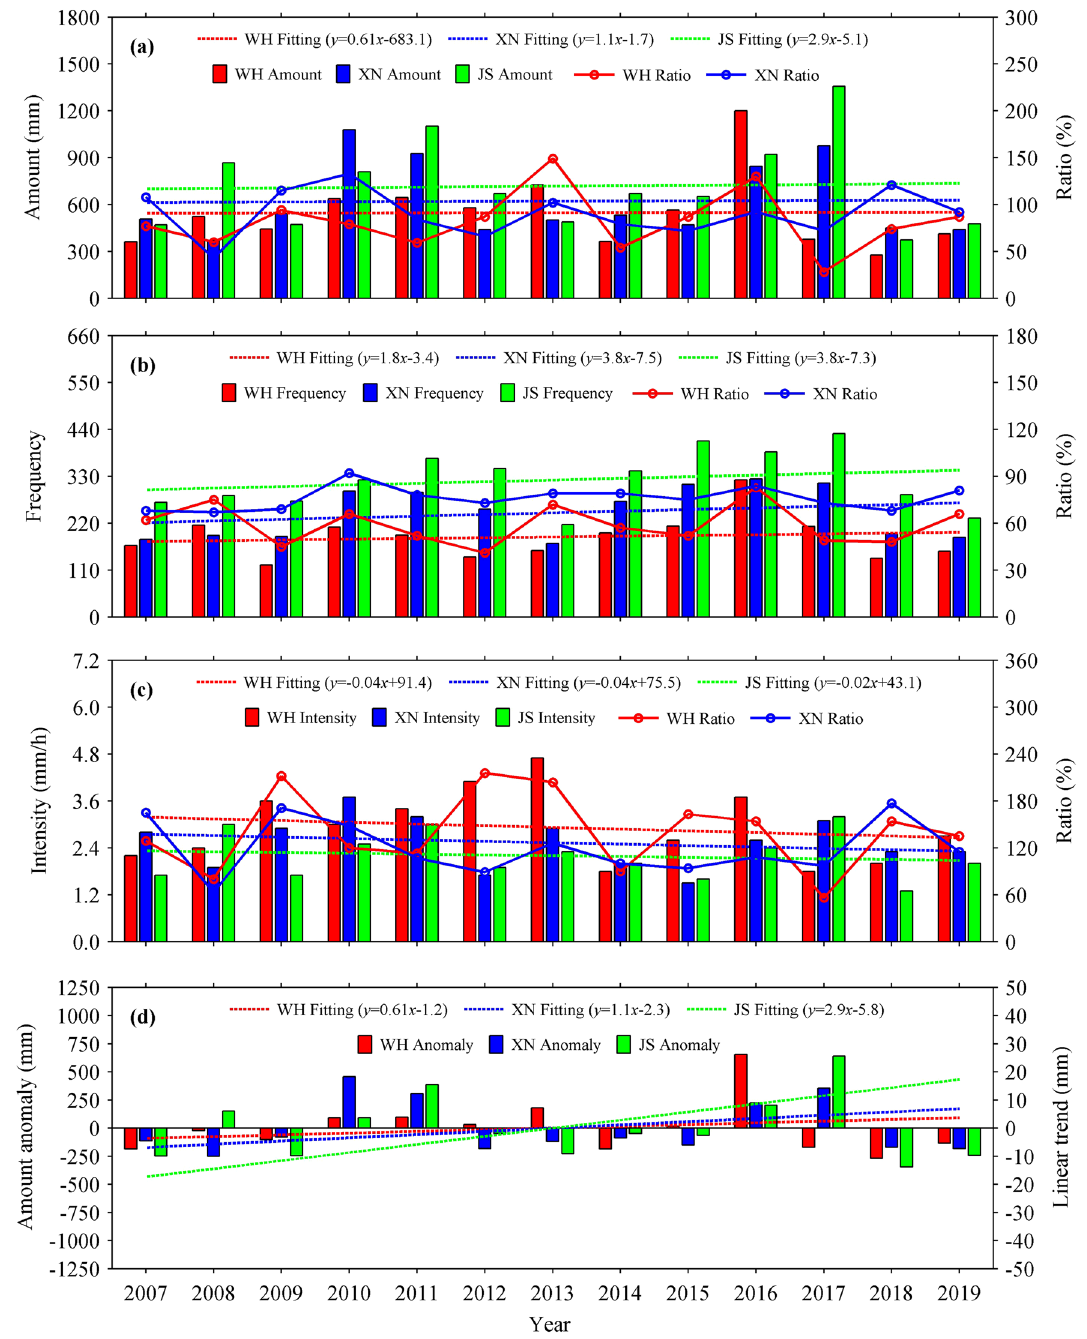
Figure 3. Interannual variations of ( a ) accumulated precipitation amount, ( b ) precipitation frequency, ( c ) precipitation intensity and ( d ) accumulated precipitation amount anomaly obtained from the summer hourly precipitation data of WH, XN and JS stations during 2007–2019. The ratio of precipitation parameter between urban stations and JS is shown in the right axis in ( a – c ), and the linear trend of accumulated precipitation amount anomaly is shown in the right axis in ( d